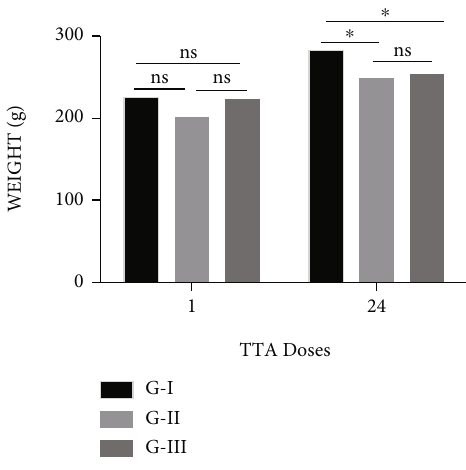
Figure 2: Average weight (g) of rats during the chronic fi brosis induction period after treatment with 24 doses of TAA, n:8. (a) Bar graph of the weight of the rats at the beginning and end of treatment. (b) ∗ p < 0 : 05 ; ns: not signi fi